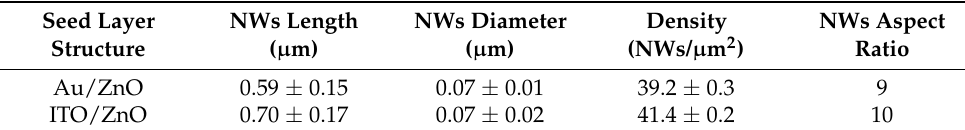
Table 2 . Morphological characteristics of ZnO NWs deposited on Au/ZnO and ITO/ZnO seed layer structures. Seed Layer Structure NWs Length (µm) ITO/ZnO